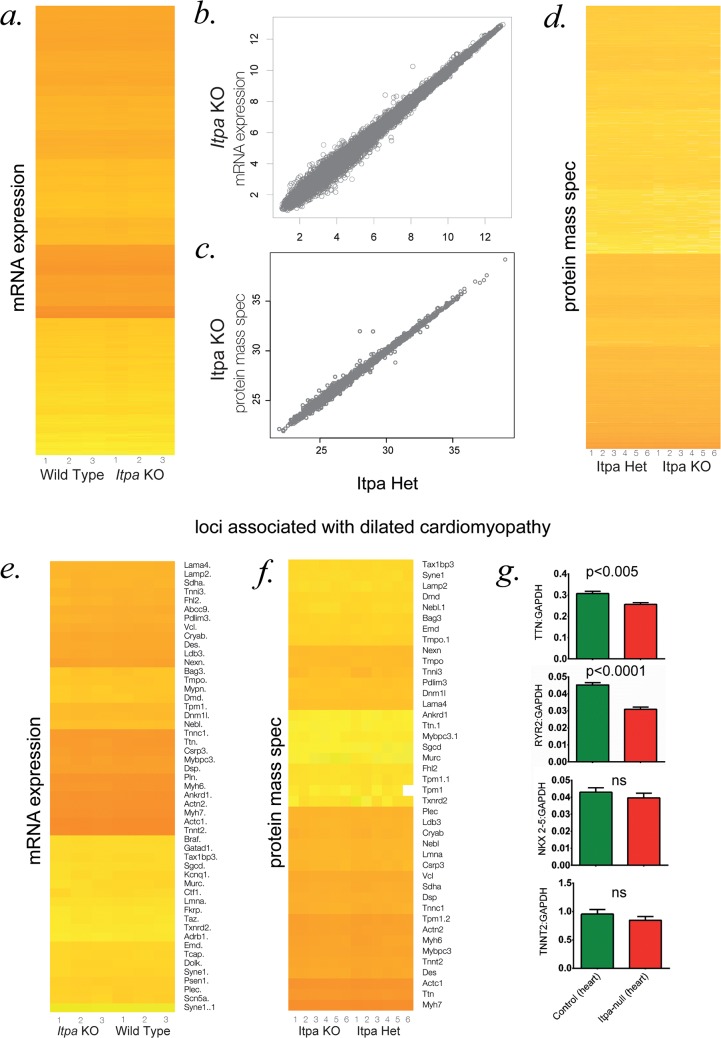
Transcriptomic and proteomic analyses of Itpa null heart.(A) Heatmap.2 based clustering of per-transcript genome wide log2 ratios from biological triplicates of RNAseq from Itpa-null embryonic hearts and littermate controls. (B,C) Plot of per-gene log2 signal from Affymetrix MTA1.0 microarray (same data as A) and quantitative protein mass spectrometry (same data as D) on samples from wild-type and Itpa-null embryonic hearts. (D) Heatmap.2 based clustering of genome wide per-protein intensity from six biological replicates of quantitative mass spectrometry from Itpa-null embryonic hearts and littermate controls. (E, F) Subset of data from A & D focussed on transcripts and proteins that are known to be involved in mendialian causes of dilated cardiomyopathy. No major differences are detectable in any of the heatmaps. (G) Quantitative RT-PCR (qPCR) of selected transcripts in Itpa-null embryonic hearts and littermate controls. The data shown are derived from analysis of 10 individual cDNA preparations per genotype, each analysed in triplicate.